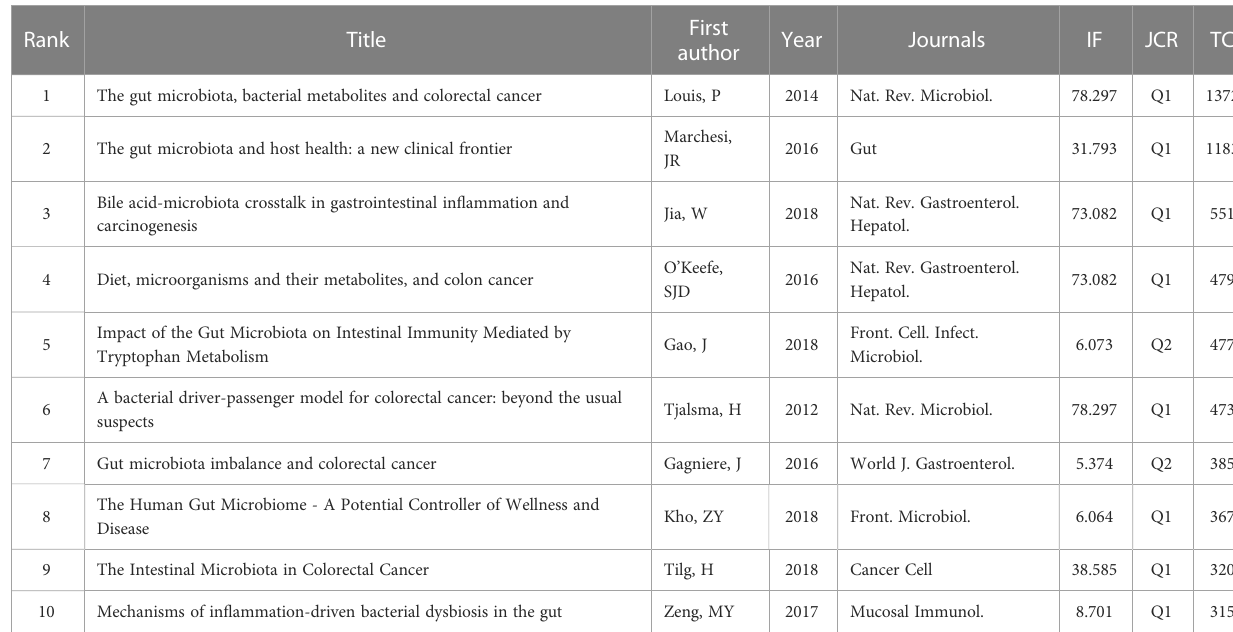
TABLE 6 The top 10 most cited reviews in